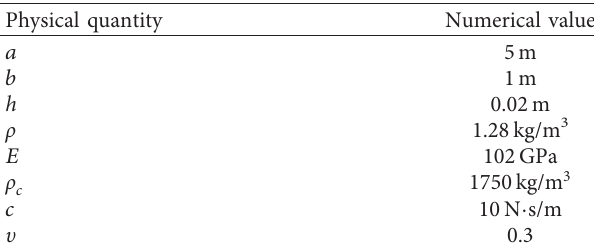
Table 1: Value of